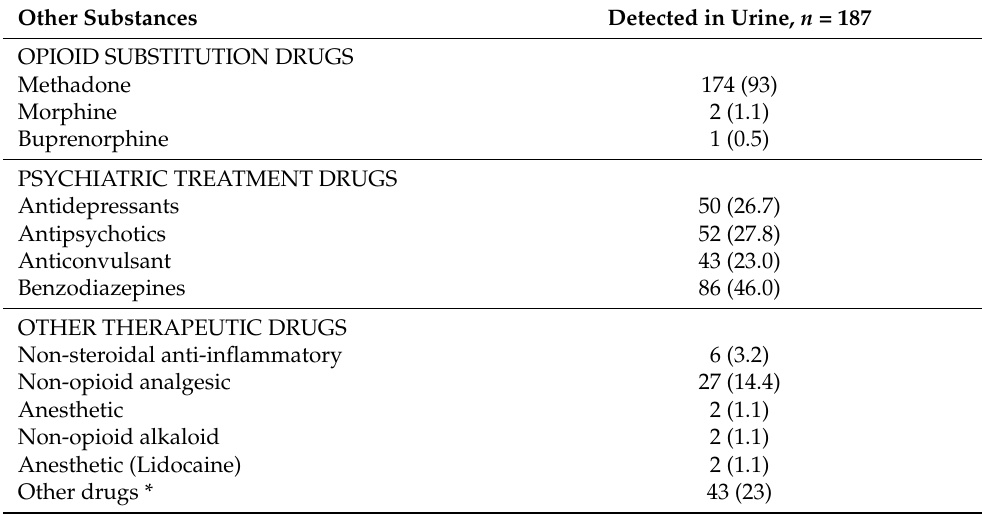
Table 2. Other detected substances and metabolites in biological samples (N =